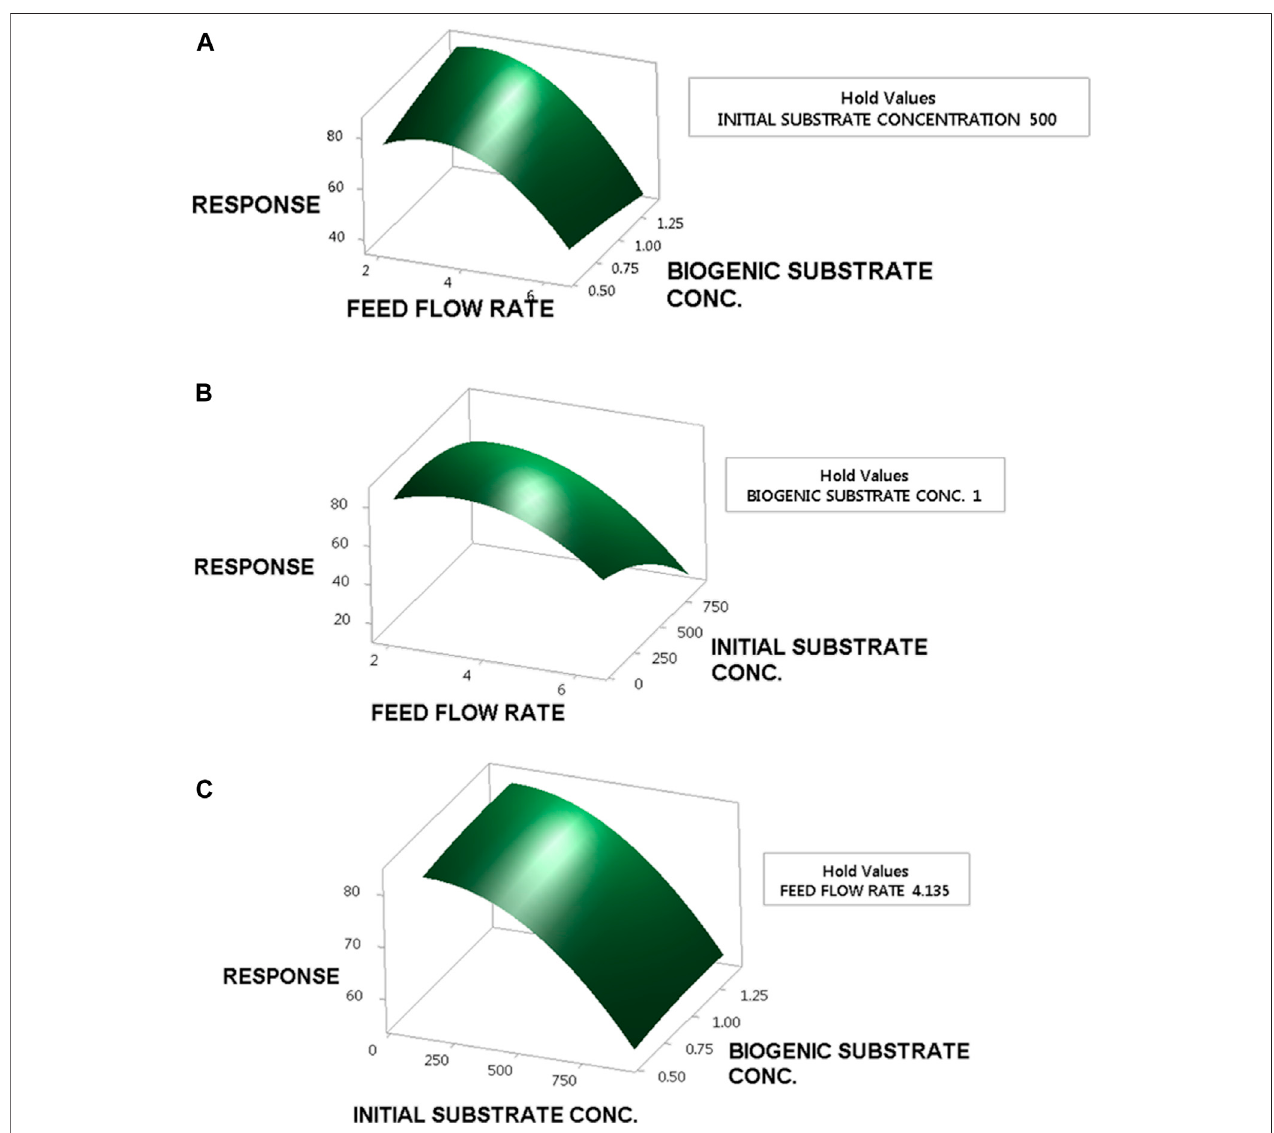
FIGURE7 | Three-dimensional plot of COD removal ef fi ciencyas afunction of (A) feed fl ow rateand additional biogenic substrate concentration; (B) feed fl ow rate and initial substrate concentration; (C) initial substrate concentration and additional biogenic substrate concentration.